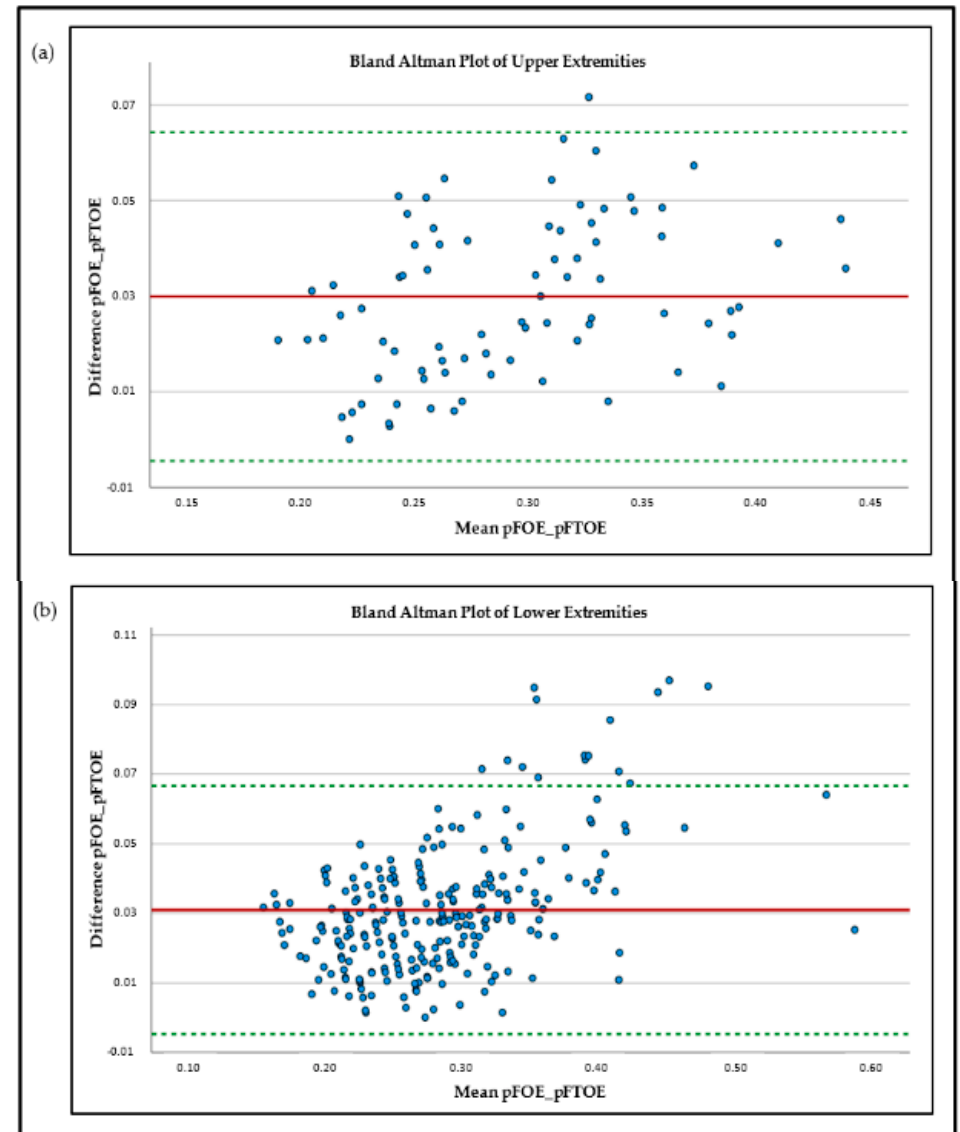
Figure 1. Bland–Altman plots of peripheral-muscle-fractional-oxygen-extraction (pFOE) and peripheral-muscle-fractional-tissue-oxygen-extraction (pFTOE) of upper extremities ( a ) and lower extremities; ( b ) NIRS measurements in neonates.